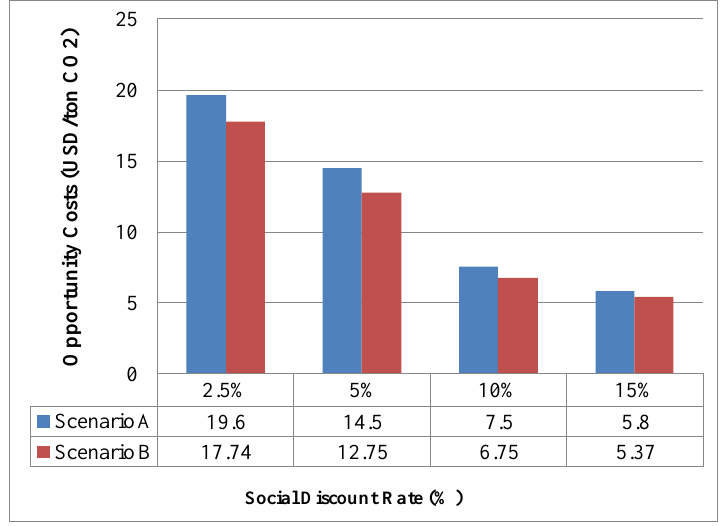
Figure 5. Sensitivity analysis of social discount rate to OC under two scenarios: (1) Scenario A: without consideration of carbon sequestration in plantations, and (2) Scenario B: with consideration of carbon sequestration in plantations.